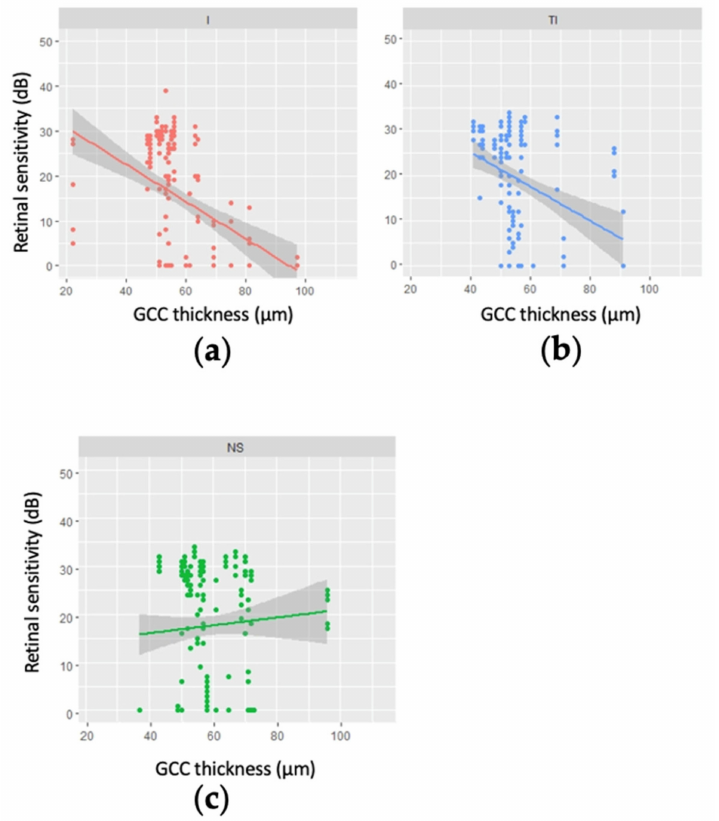
Figure 2. Linear regression modelling of retinal sensitivity as a function of ganglion cell complex (GCC) thickness for regions of the 10-2 visual field for 27 patients (29 eyes) with advanced glaucoma. ( a ) the inferior region—the regression slopes ranged from − 0.48 to − 0.33 ( p = 0.01–0.09); ( b ) the inferior temporal region—the regression slopes ranged from − 0.37 to − 0.21 ( p = 0.05–0.19); ( c ) the nasal superior region—none of the regression slopes were statistically significant ( p > 0.3) and the coefficients of determination were low (R 2 <